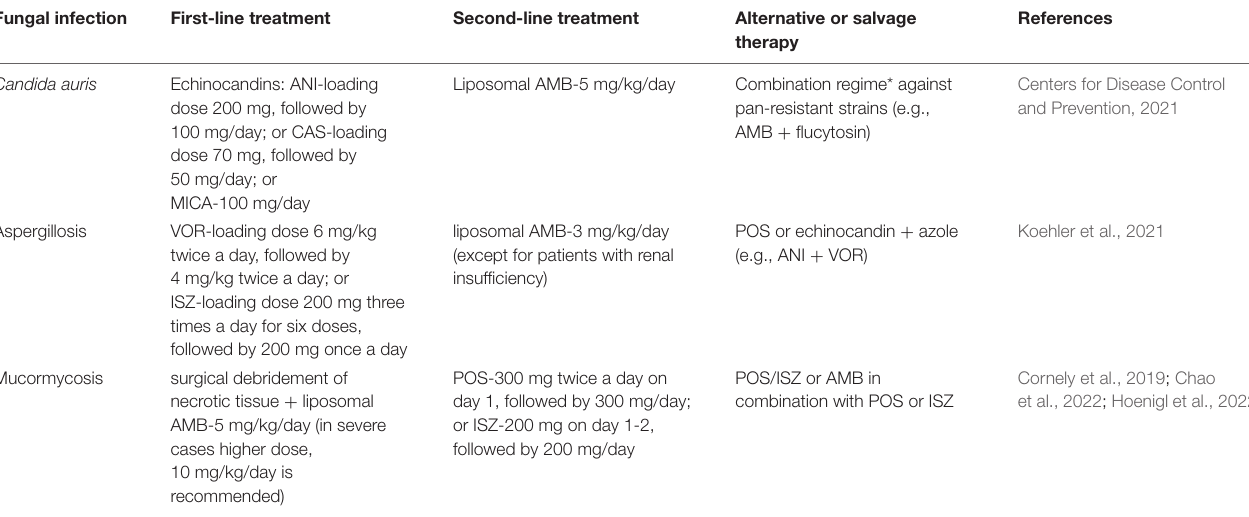
TABLE 2 | Recommendations for the management of fungal co-infections in COVID-19